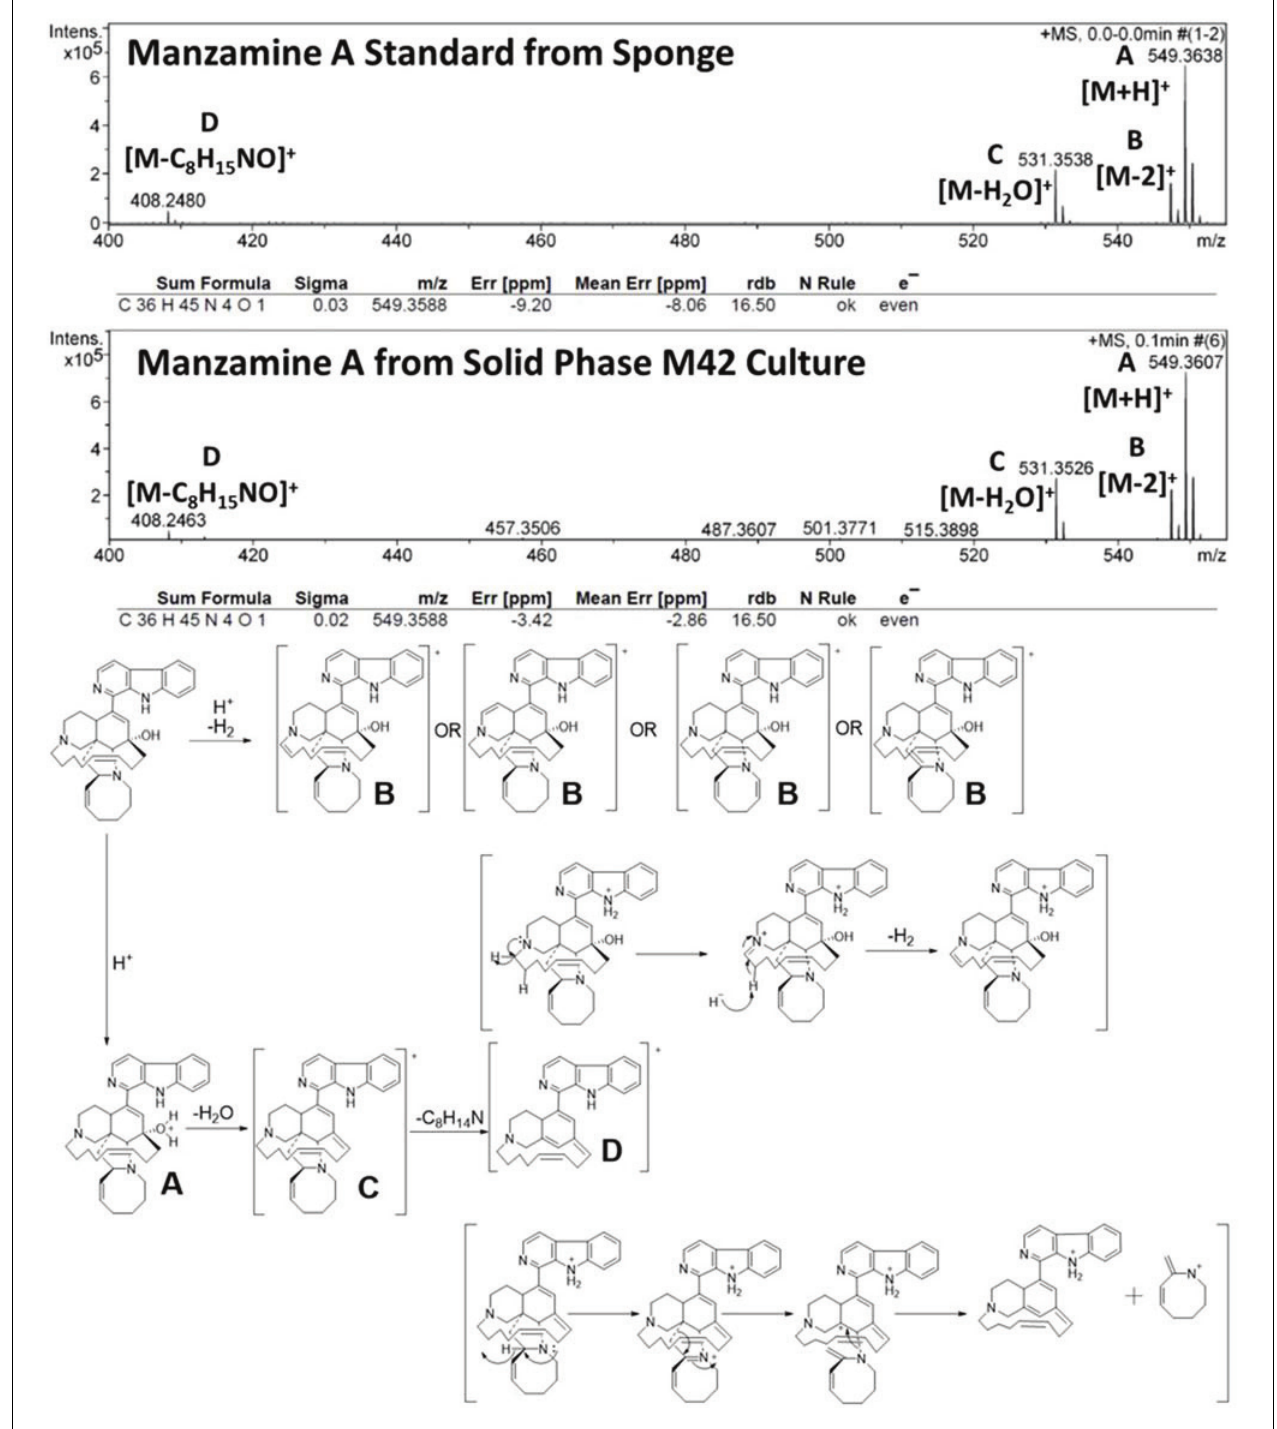
FIGURE 7 | HRESIMS from extracts of solid phase growth of M42 on ISP2.